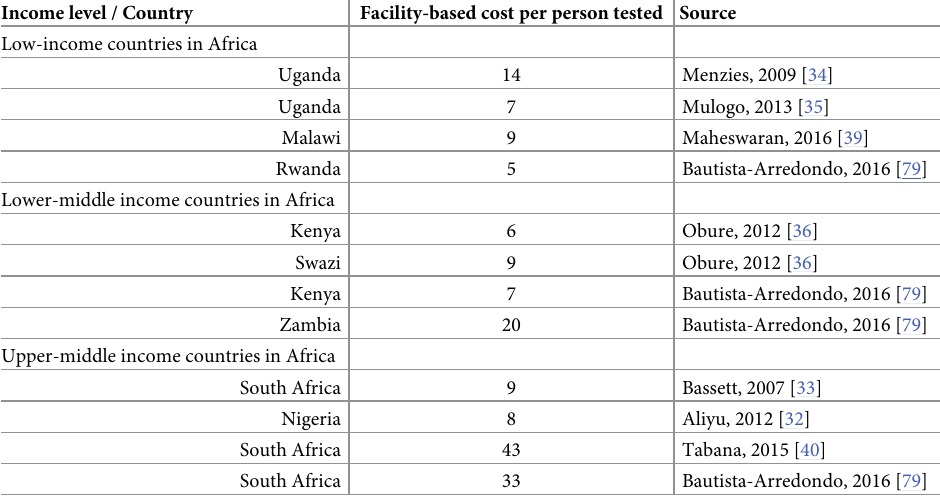
Table 1. Review of facility-based HIV testing costs per person in Africa (2017